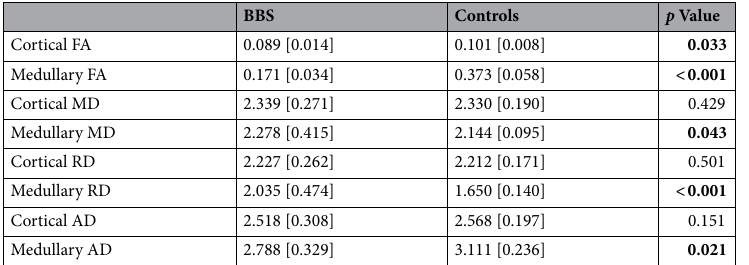
Table 2. Bardet–Biedl syndrome (BBS) and controls median and interquartile ranges (in square brackets) for DTI parameters from both the cortical and medullary regions. FA: fractional anisotropy; MD: mean diffusivity; RD: radial diffusivity; AD: axial diffusivity. FA values are expressed in arbitrary units, whereas MD, RD and AD values are reported in 10 –3 mm 2 /s. p-values < 0.05 are represented in bold.